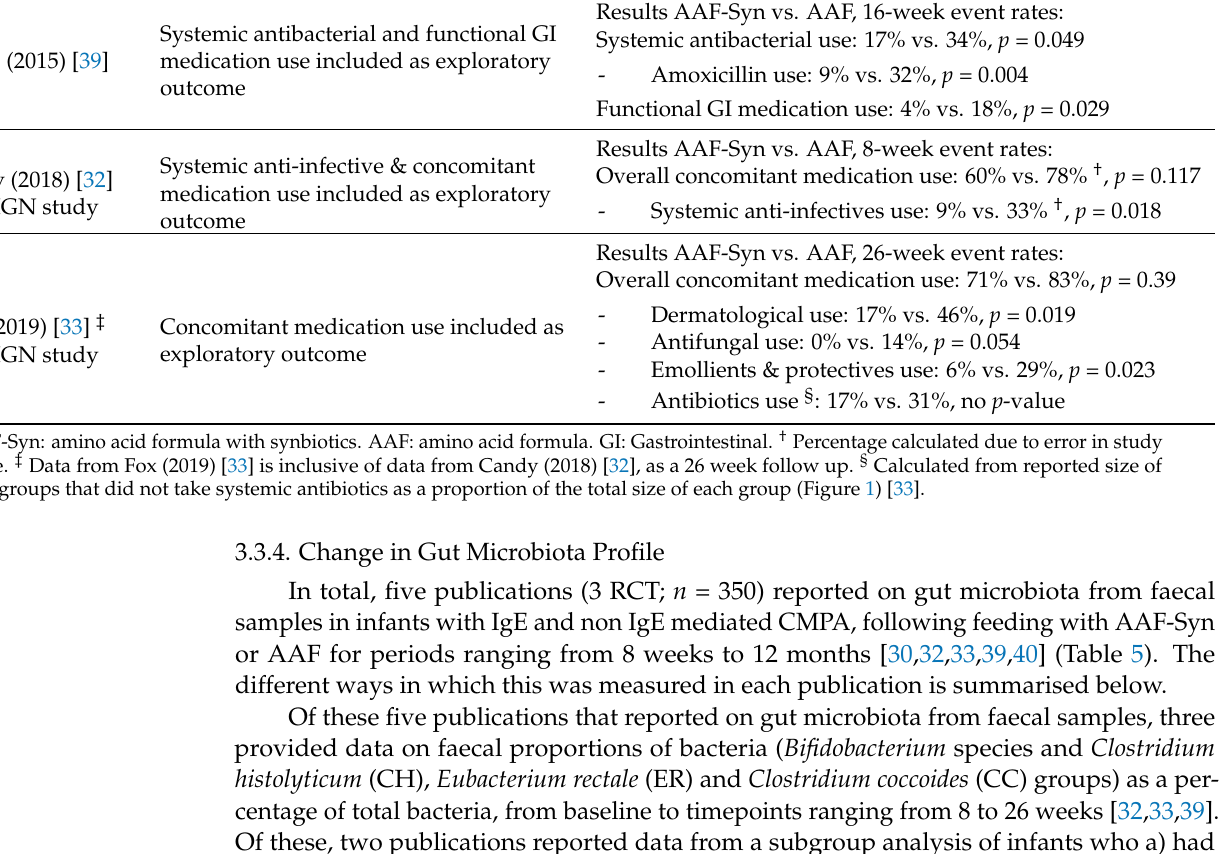
Table 4. Individual publication results of the percentage of infants receiving medications with AAF-Syn vs. AAF. Outcome Measures Comparison of Findings in AAF-Syn vs. AAF